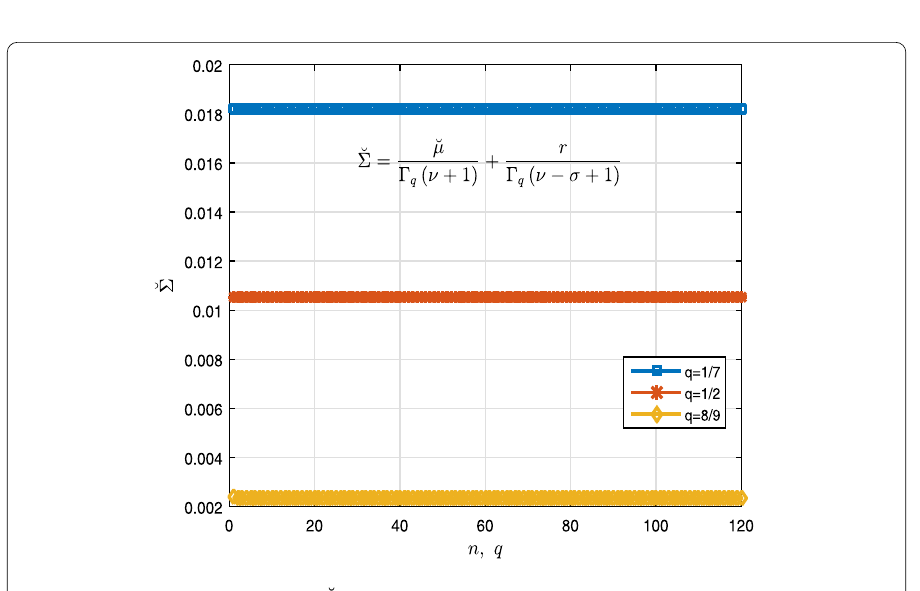
Figure 4 Graphical representation of ˘ (cid:21) in Example